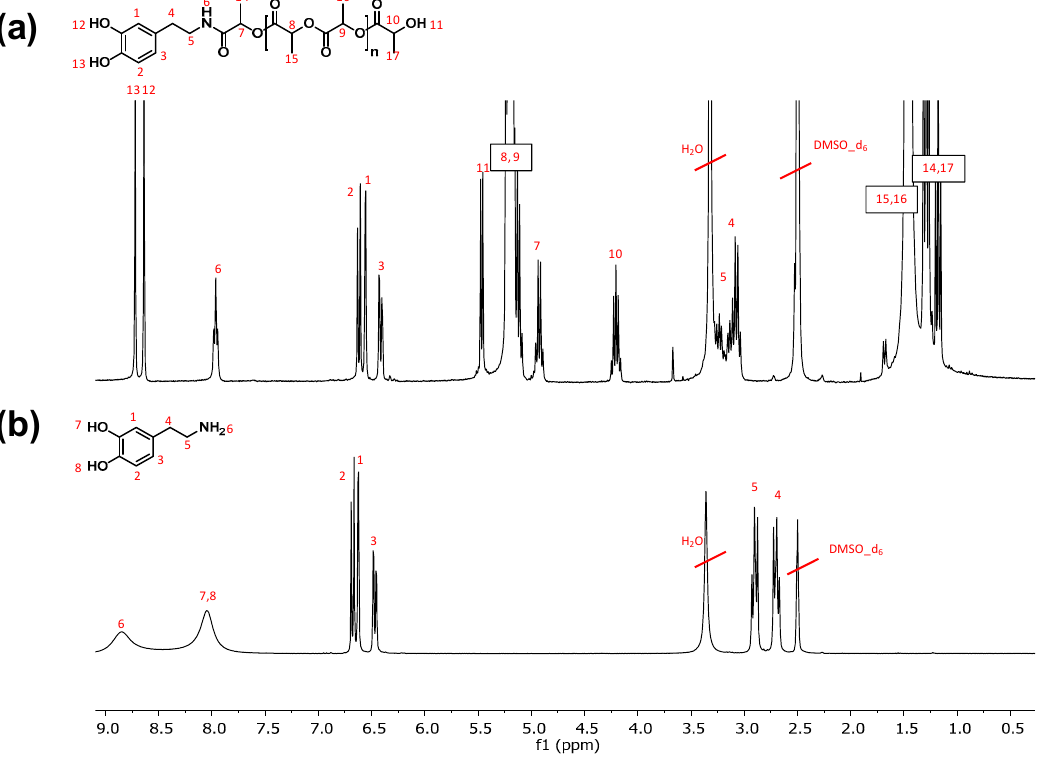
Figure 1. 1 H NMR spectra in DMSO-d 6 for ( a ) Catechol end-functional PLLA with DP 10 and ( b ) Dopamine initiator.